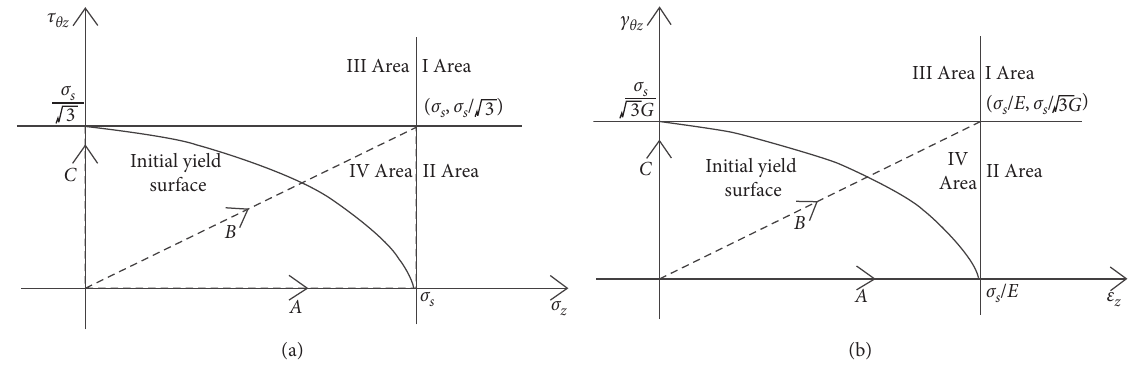
Figure 8: Stress (a) and strain (b) path loading